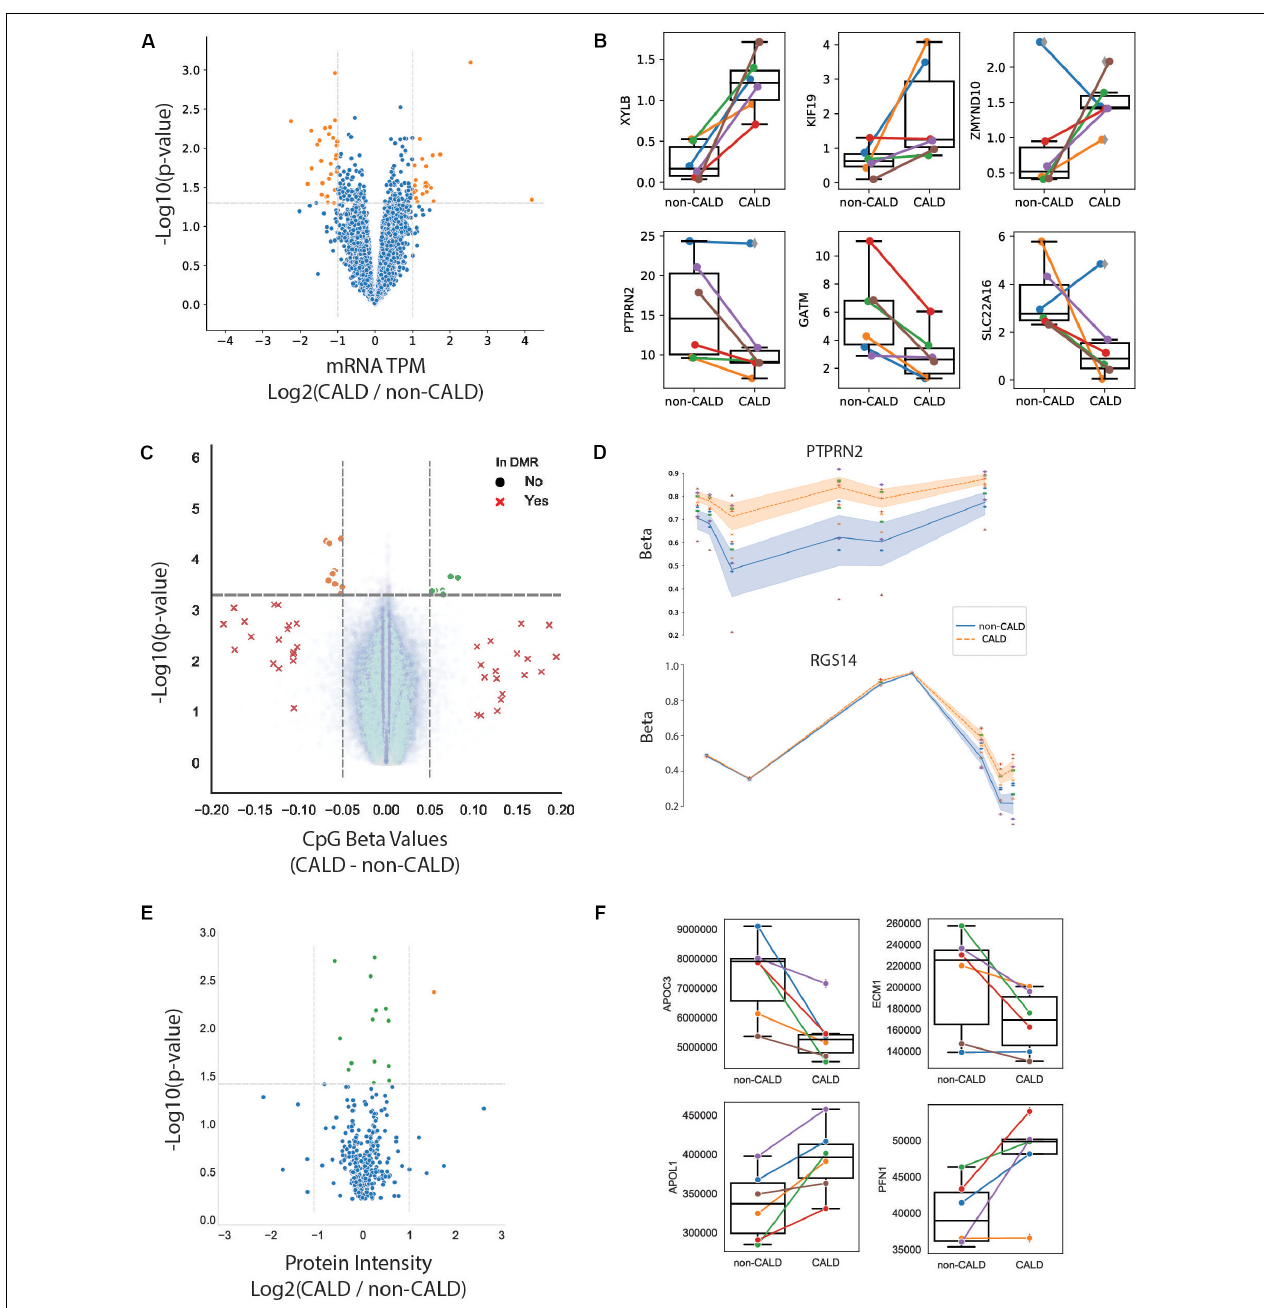
FIGURE 4 | Multi-omic analysis. (A) Volcano plot showing p -value and log2 fold change of gene expression from RNA-seq. Significant genes at p < 0.05 (orange dots), non-significant genes (blue dots). (B) Selected genes plotted as normalized RNA-seq values with boxplots for each group where each line/point is colored by family. (C) Volcano plot of DNA methylation over CpG probes from EPIC array, with non-significant ( p > 0.05) DMR probes (blue dots), significant CpGs at the DMR level (red Xs), higher methylated non-CALD probes (orange dots), and higher methylated CALD probes (green dots). (D) DNAm over two significant DMRs within PTPRN2 and RGS14 , points colored by family and lines colored by phenotype, with shading denoting inner quartile range. (E) Volcano plot of protein levels from LCMS with non-significant proteins (blue), significant proteins with log2 fold-change (CALD/non-CALD) of –1 to 1 (green), and log2 fold-change greater than 1 (orange). (F) Selected proteins which passed the p -value threshold of